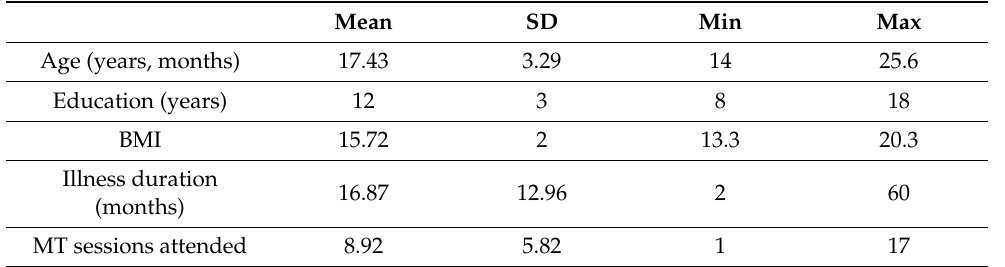
Table 1. Demographic and clinical characteristics of the